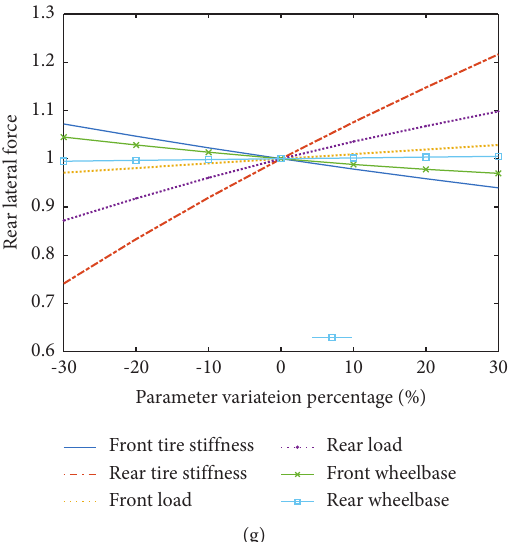
Figure 17: Vehicle lateral stability sensitivity versus vehicle parameter variation. (a) Front tire sideslip angle. (b) Rear tire sideslip angle. (c) Vehicle sideslip angle. (d) Yaw rate of vehicle front part. (e) Yaw rate of vehicle rear part. (f) Front lateral force. (g) Rear lateral